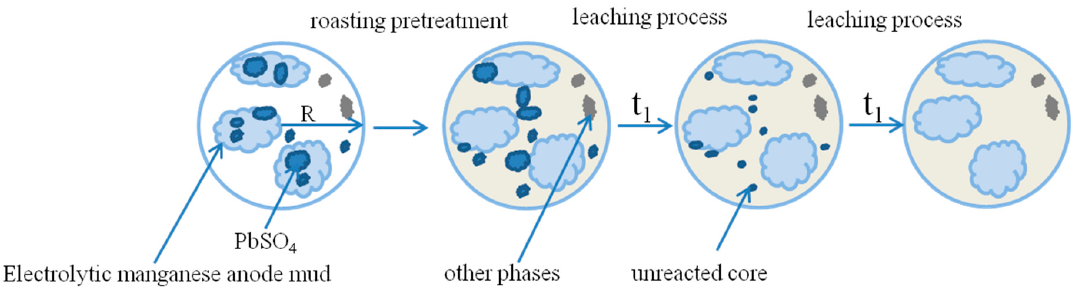
Figure 17. Sketch of the unreacted shrinking core model. (t 1 is reaction time).